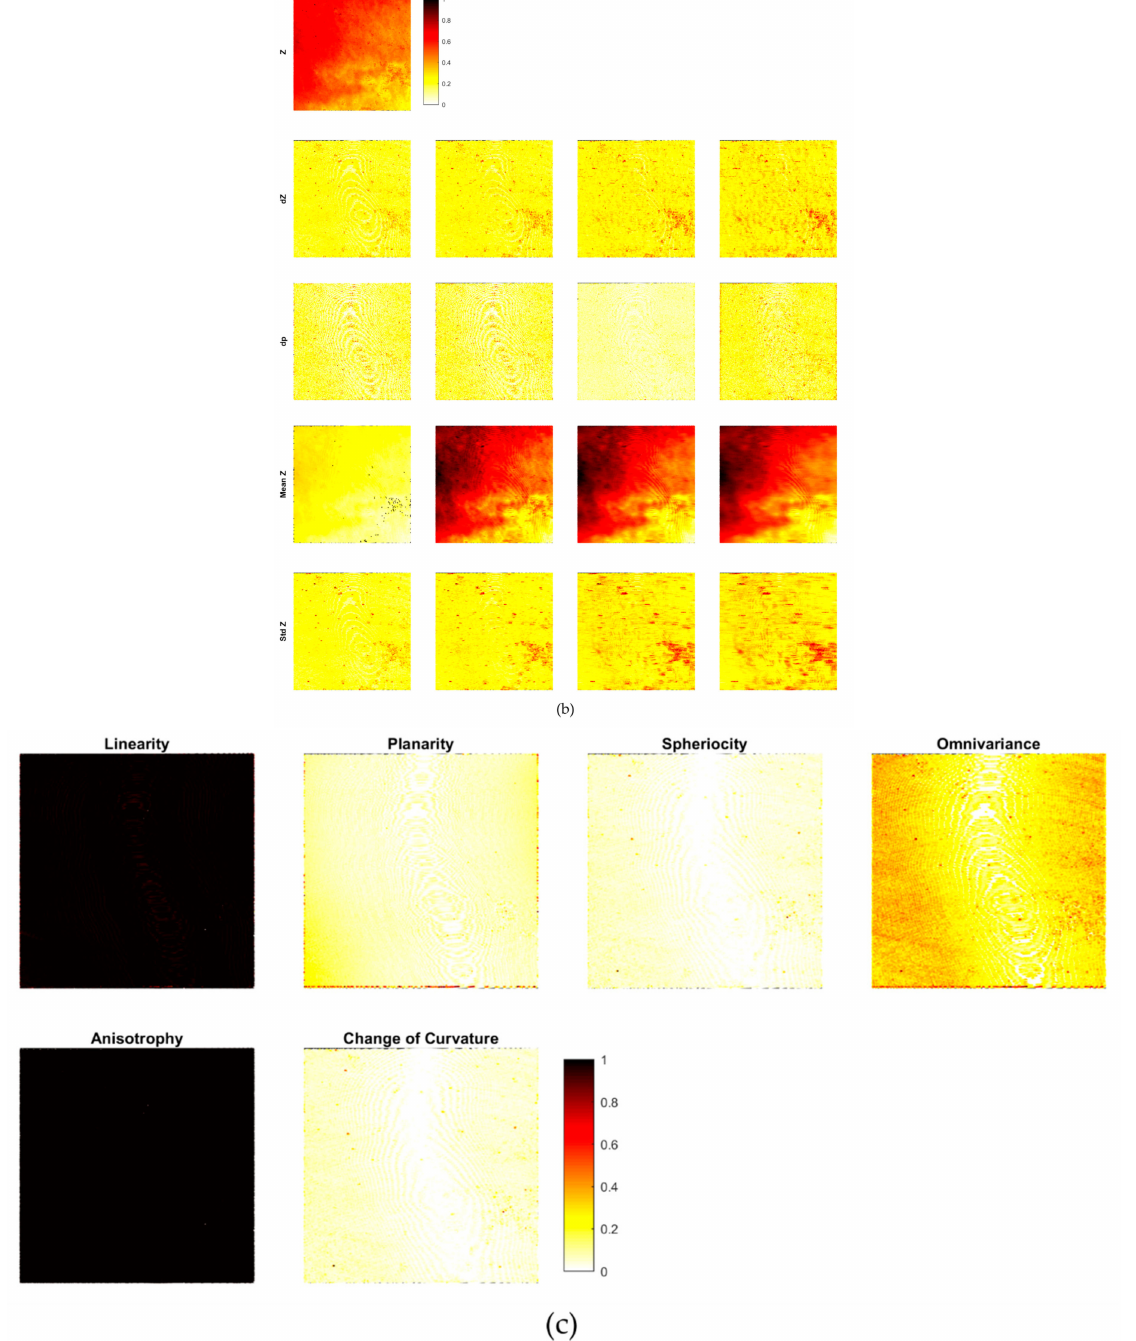
Figure 8. Features in the area: ( a ) spectral features, ( b ) relative position features, and ( c ) covariance